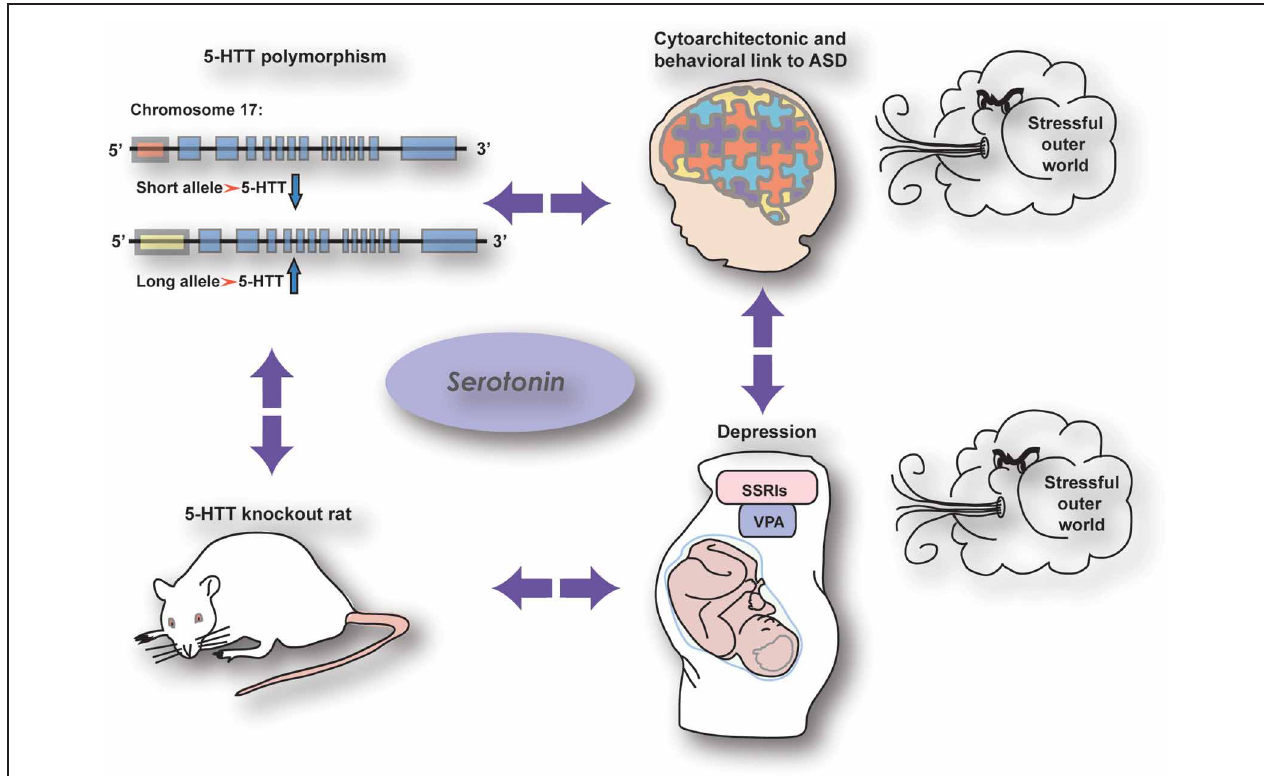
FIGURE 1 | The relationship between serotonergic genetic and pharmacological manipulations with common effects on brain wiring and behavior.